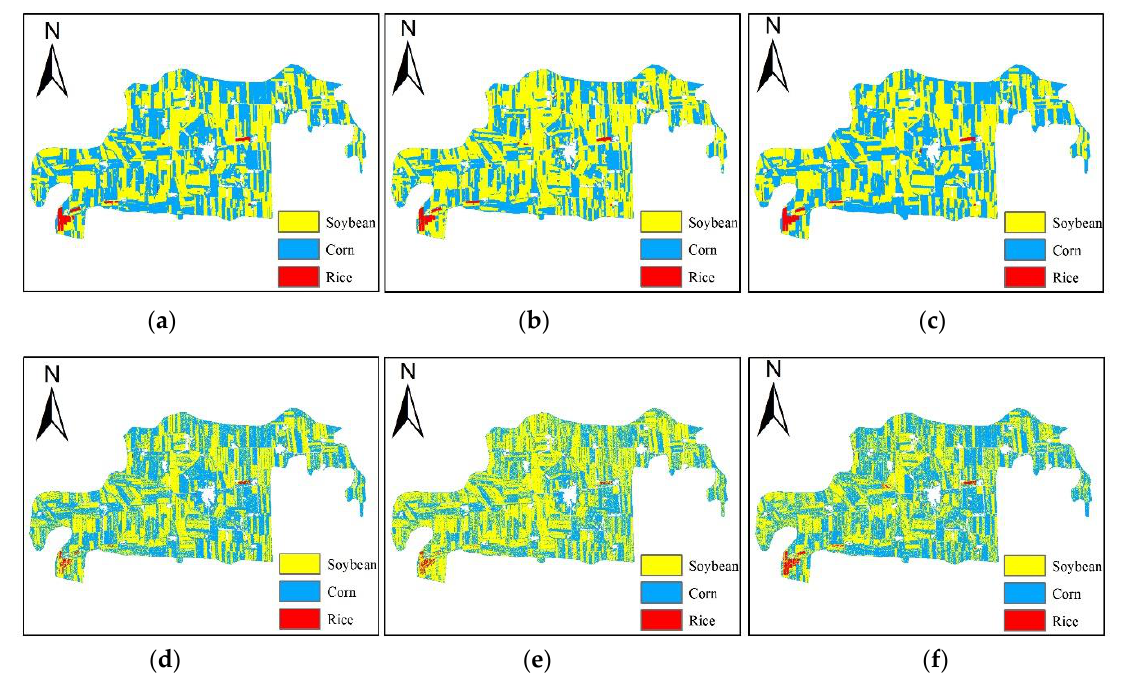
Figure 5. Crop classification results of highest crop classification accuracy with different time intervals in Keshan farm at 2019 (( a ), 10d_size25; ( b ), 15d_size25; ( c ), 30d_size40; ( d ), 10d_Pixel; ( e ), 15d_ Pixel; ( f ), 30d_ Pixel).